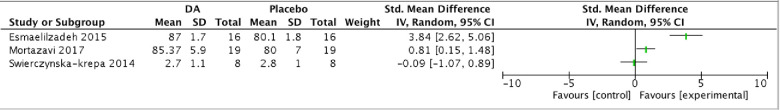
Forest plot of comparison.Aspirin desensitization vs placebo, outcome: Pulmonary function (VEF1).